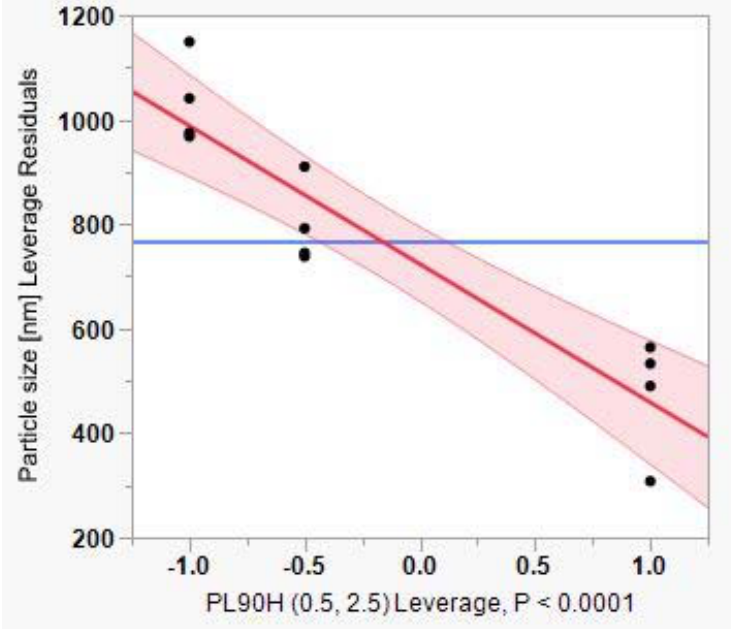
Figure 6. Leverage plot for the whole model of actual vs. predicted particle size.